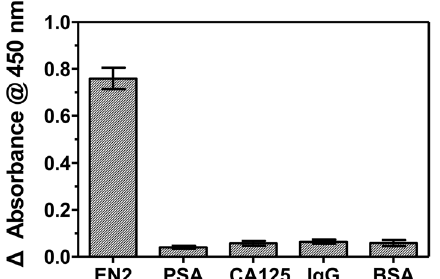
Figure 5. Specificity test with various proteins at 50% AUM. 30 nM of EN2 and 150 nM of other proteins were used for testing. Bars: ± s.d., n = 3.